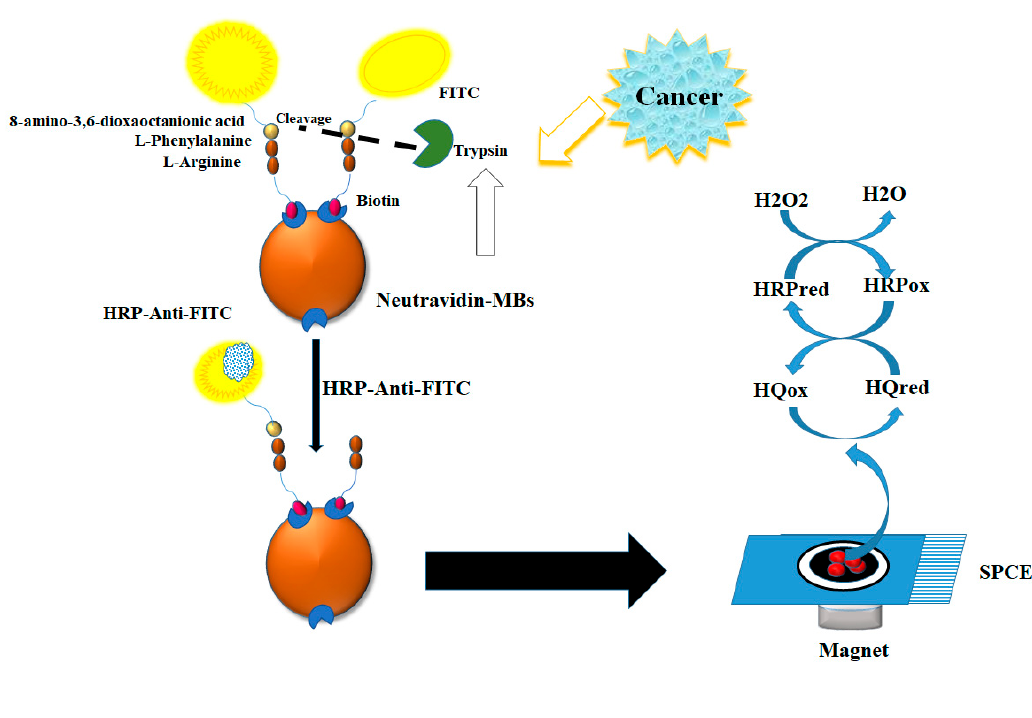
Figure 3. ( a ). The important components of a designed biosensor. A single or a multiple bio-recep- tors (could be whole cells, microorganisms, enzymes, or antibodies). A transducer of the physico- chemical signals resulted from the analyte and bio-recognition elements interaction(s). Data proces- sor to interpret and amplify the results that have been converted [52,54]. ( b ). Schematic